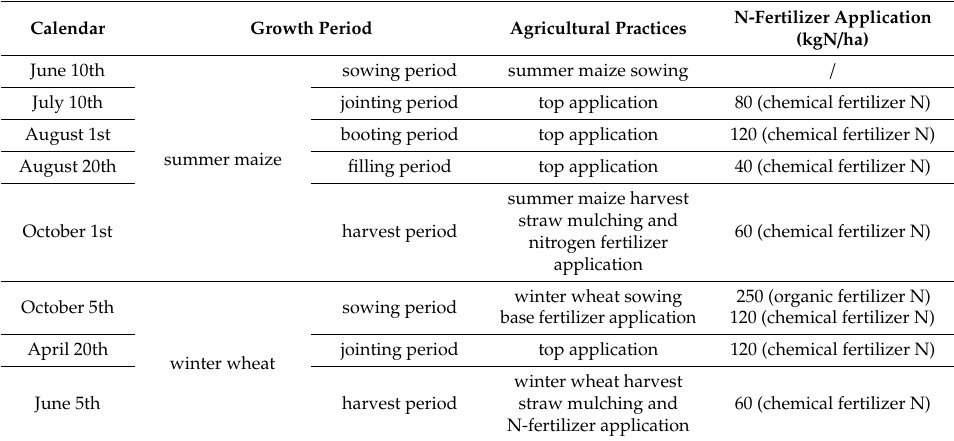
Table 1. Nitrogen fertilizer application